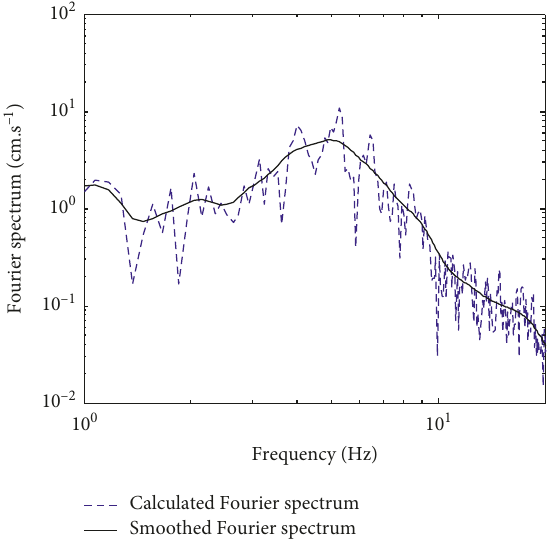
Figure 5: The calculated and smoothed Fourier spectrum of the NS component at 051YBT in Changning mainshock after